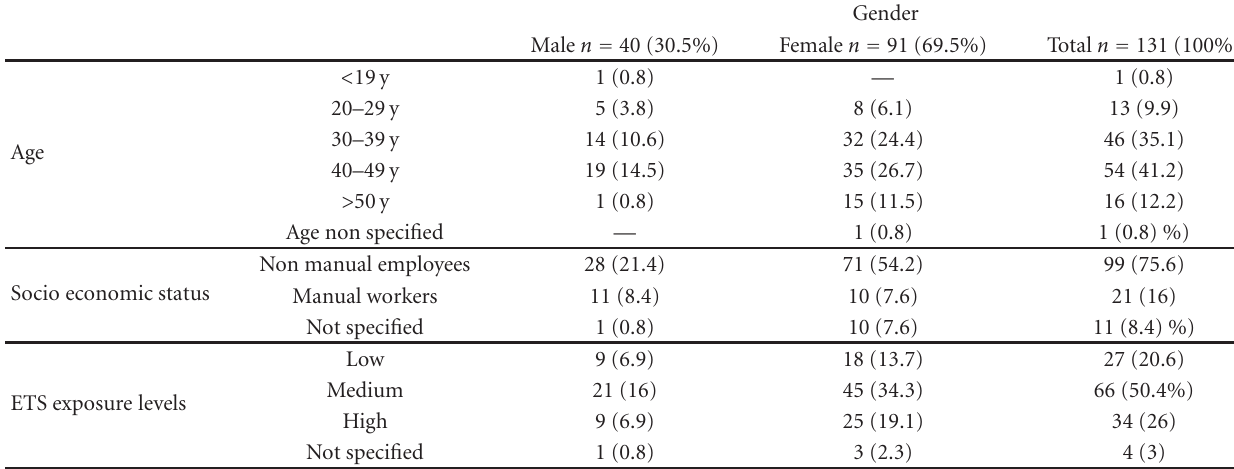
Table 1: Demographic characteristics, socioeconomic status, and ETS levels concerning 131 nonsmoker workers exposed to PSW.